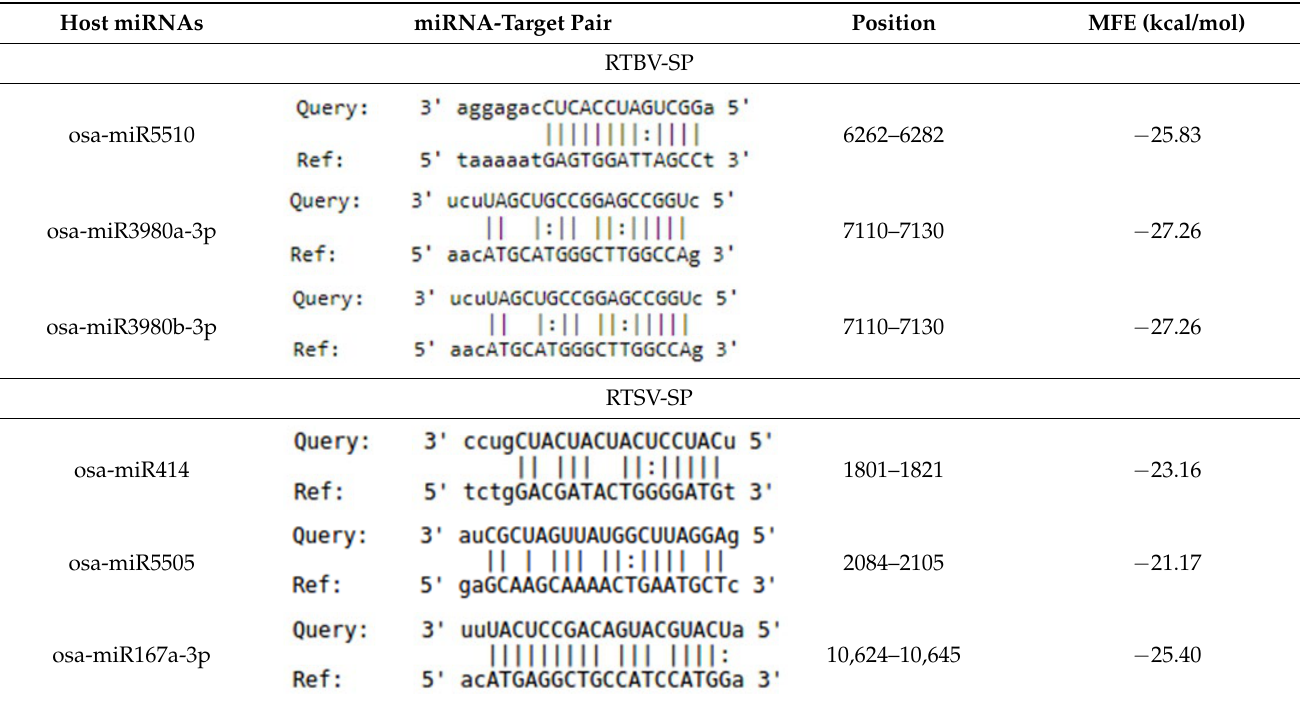
Table 2. MiRanda’s algorithm analysed the outcome of miRNA-target pairs. Algorithm generated an miRNA-target pair, MFE (Minimum Free Energy), locus of the targeted position.